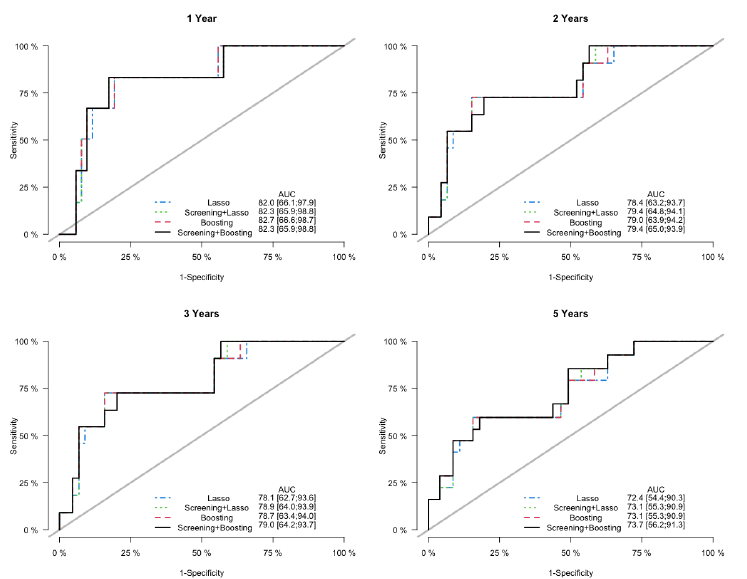
Figure 6. Sensitivity Analysis: ROC curves and assocaited AUC values of the cumulative incidence predicted by the competing models on the testing data, at years 1, 2, 3 and